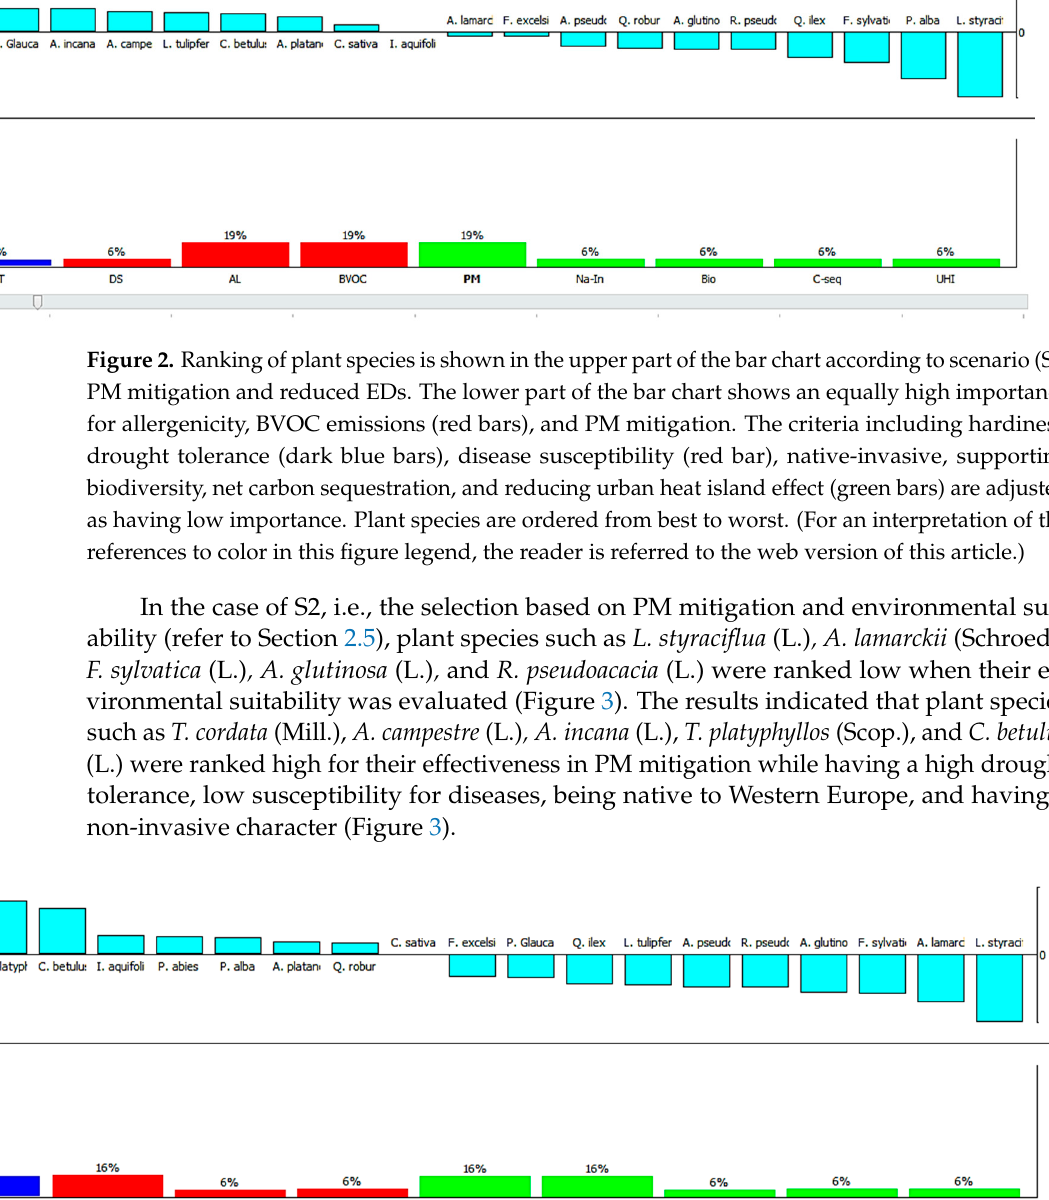
Figure 3 . Ranking of plant species shown in the upper part of the bar chart according to scenario (S2) PM mitigation and environmental adaptability. The lower part of the bar chart shows an equally high importance for hardiness, drought tolerance (dark blue bars), disease susceptibility (red bar), PM mitigation, and native-invasive (green bars). The criteria including allergenicity, BVOC emis- sions (red bars), supporting biodiversity, net carbon sequestration, and reducing urban heat island effect (green bars) are adjusted as having low importance. Plant species are ordered from best to worst. (For an interpretation of the references to color in this figure legend, the reader is referred to the web version of this article.)